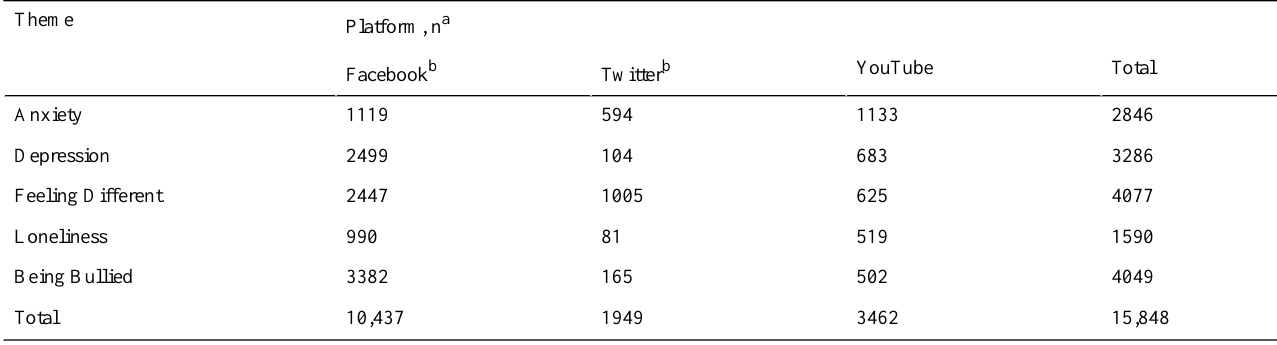
Table 1. Viewing figures across SpunOut Facebook, Twitter, and YouTube